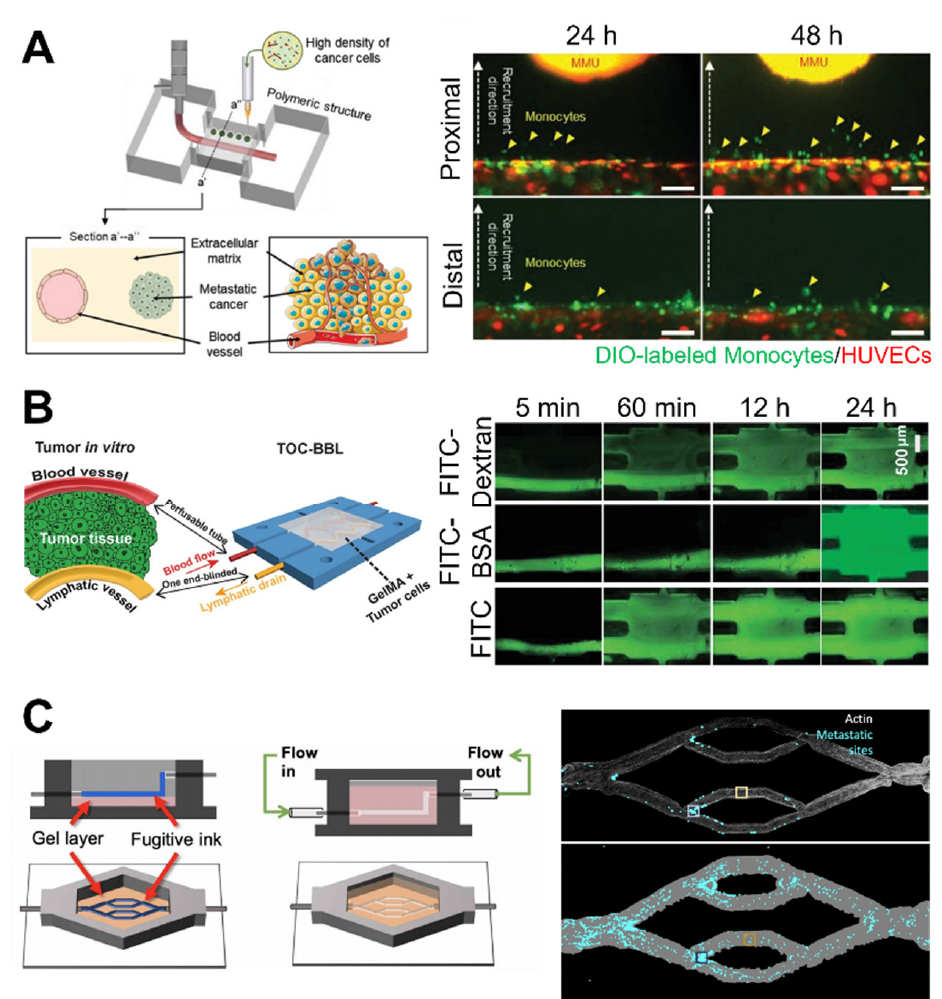
Figure 5. Examples of 3D bioprinted in vitro cancer models. ( A ) Bioprinted tissue-level cancer/vascular model used for the study of tumor metastasis based on precise-positioning. Reprinted with permission from ref. [111]. Copyright 2021 John Wiley and Sons. ( B ) Bioprinted tumor-on-a-chip system with blood and lymphatic vessel pair for the study of diffusion profiles of biomolecules and anticancer drugs. Reprinted with permission from ref. [112]. Copyright 2019 John Wiley and Sons. ( C ) Bioprinted vasculature for the study of the metastatic behavior of cancer cells. Reprinted with permission from ref. [113]. Copyright 2020 The Authors, some rights reserved; exclusive licensee American Association for the Advancement of Science.